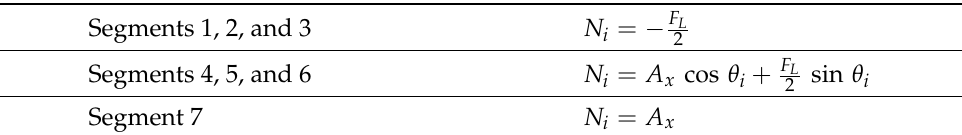
Table 1. Normal force N i in each segment i .